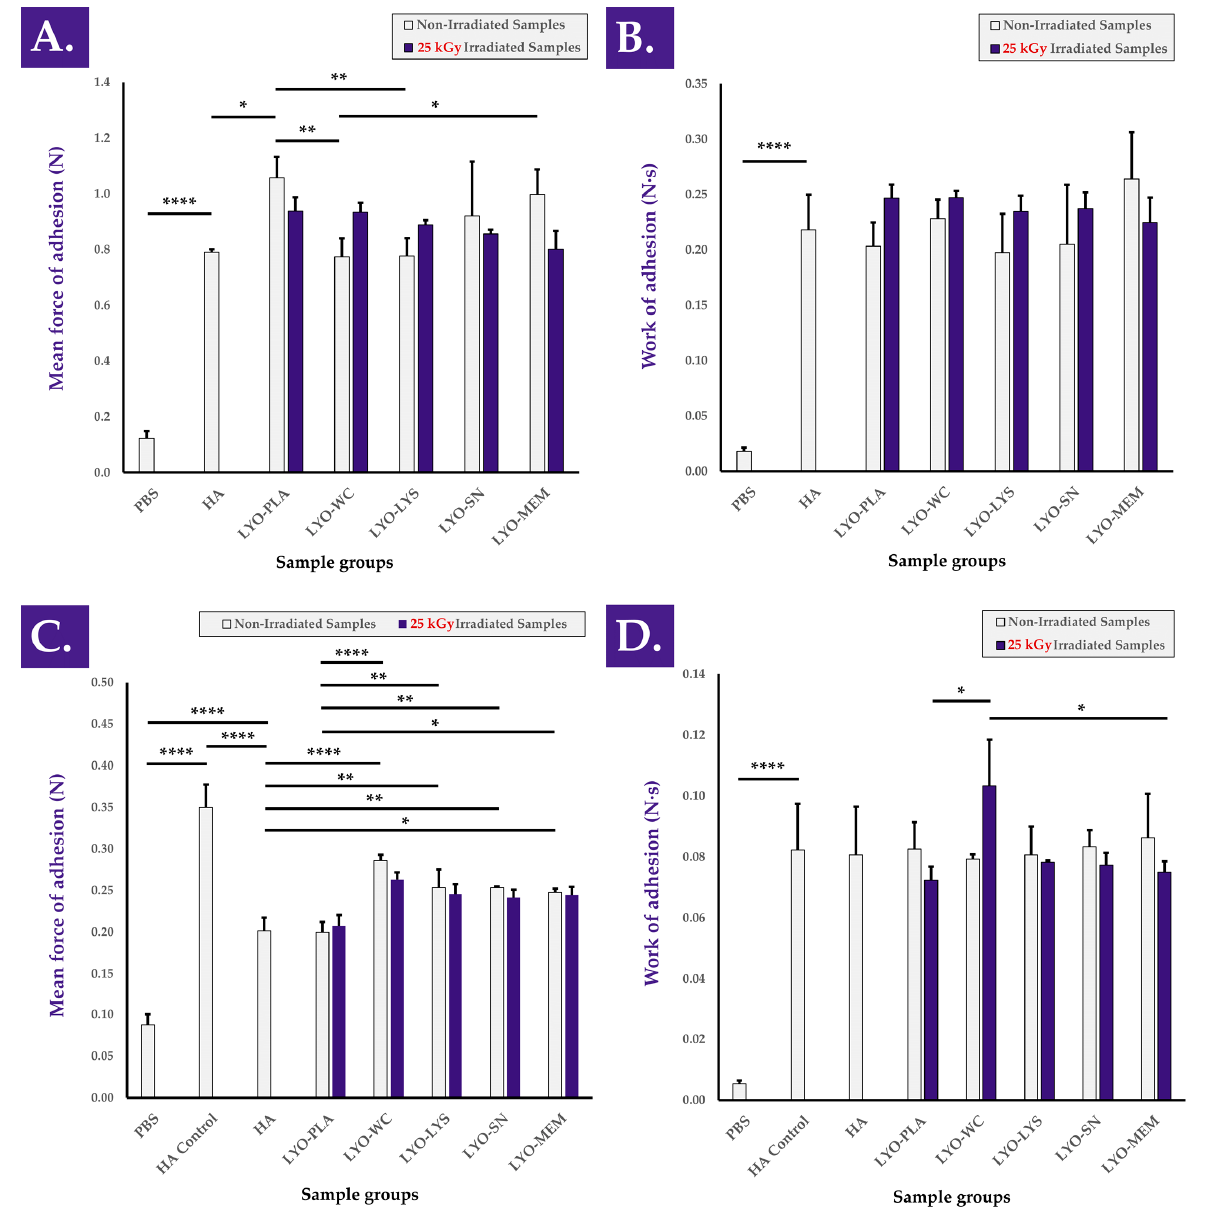
Figure 7. Results of the ex vivo bioadhesion assays for hydrogel combination product samples containing non-irradiated or gamma-irradiated (i.e., 31 kGy) cellular extracts. Panels ( A , B ) express different parameters of the same force profiles (i.e., analysis of unchallenged samples). Similarly, panels ( C , D ) express different parameters of the same force profiles (i.e., analysis of H 2 O 2 -challenged samples). ( A ) Mean force of adhesion values of the various hydrogel samples compared to PBS. ( B ) Mean work of adhesion values of the same hydrogel samples compared to PBS. ( C ) Mean force of adhesion values of the various H 2 O 2 -challenged hydrogel combination product samples compared to unchallenged PBS and unchallenged linear HA controls. ( D ) Mean work of adhesion values of the same H 2 O 2 -challenged hydrogel samples compared to unchallenged PBS and unchallenged linear HA controls. Significant statistical differences (i.e., * or p value < 0.05), very significant statistical differences (i.e., ** or 0.001 < p value < 0.01), or extremely significant statistical differences (i.e., **** or p value < 0.0001) were found between the presented mean values. HA, hyaluronic acid; kGy, kiloGray; LYO-LYS, lyophilized lysate fraction; LYO-MEM, lyophilized membrane fraction; LYO-PLA, lyophilized placebo sample; LYO-SN, lyophilized soluble fraction; LYO-WC, lyophilized whole-cell fraction; N, Newton; PBS, phosphate-buffered